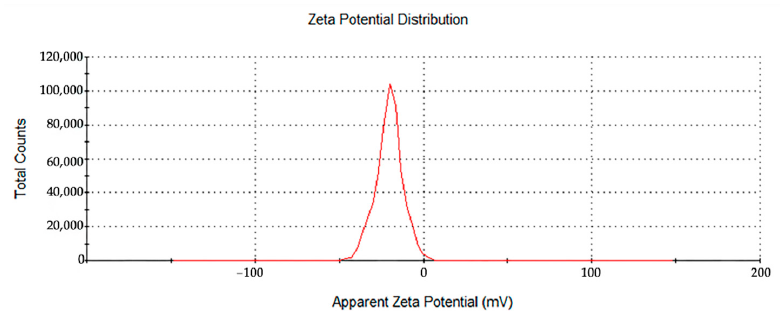
Figure 5. Zeta potential distribution of the GL-reduced AgNPs.